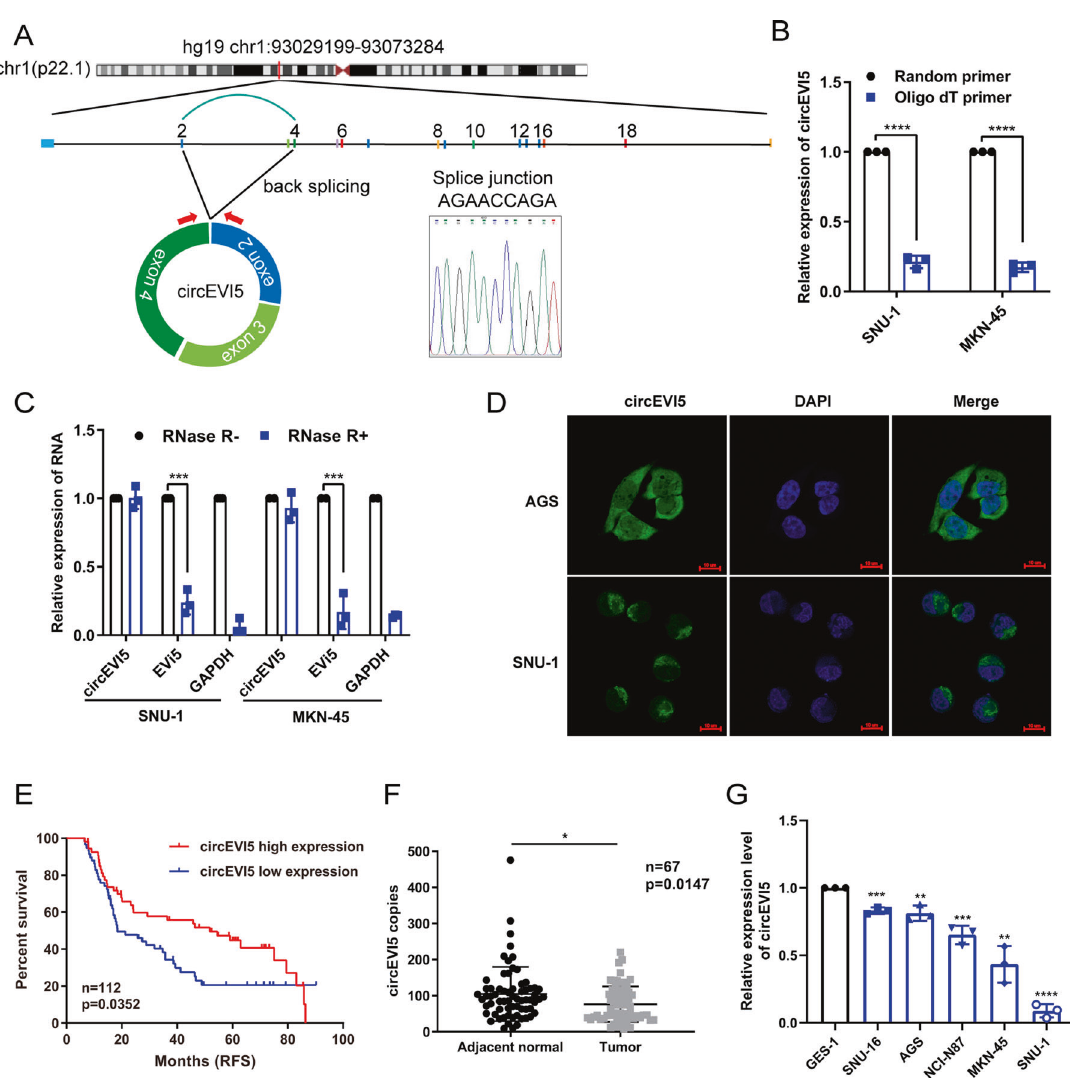
Fig. 1 circEV15 was downregulated in GC, and low circEV15 expression was correlated with poor prognosis. A Schematic illustration of the formation of circEVI5. Sanger sequencing con fi rmed the back splice site of circEVI5. B The template cDNA of circEVI5 reverse transcribed by random primers or oligo dT primers was analyzed by qRT-PCR in SNU-1 and MKN-45 cells. C qRT-PCR analysis of circEVI5 expression in SNU-1 and MKN-45 cells treated with or without RNase R. D FISH assay showed circEVI5 (green) localized in the cytoplasm, and nuclei were stained with DAPI (blue), scale bar, 10 μ m. E The RFS curve was drawn using the Kaplan-Meier method ( n = 112). Low circEVI5 expression showed a poor RFS ( p = 0.0352). F circEVI5 expression was measured by qRT-PCR in 67 pairs of GC (Tumor) and matched normal tissues (Adjacent normal). G The expression levels of circEVI5 in GC cell lines were evaluated by qRT-PCR. Data were shown as the mean ± SD of three independent experiments. * p < 0.05, ** p < 0.01, *** p < 0.001, **** p <